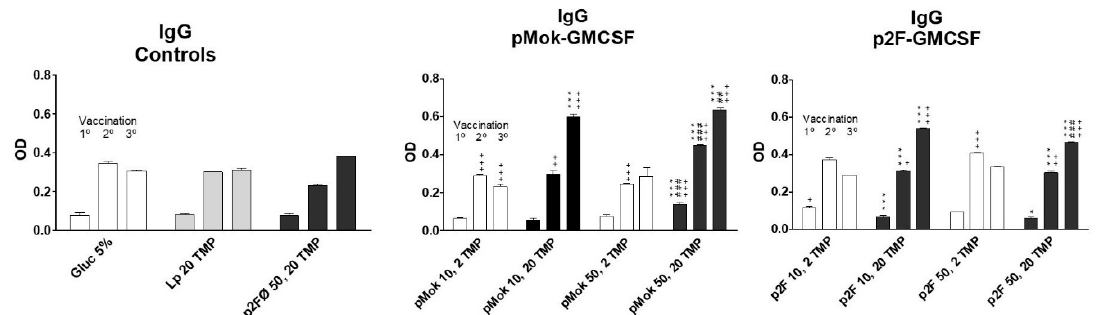
Figure 4. Total IgG response obtained after each vaccination dose in the different formulations of multicompartmental lipopolyplex loaded with a water-soluble protein extract (TMP). Lipolyplexes contained 10 or 50 µg of plasmid (pMok or p2F) bearing murine GM-CSF gene and 2 or 20 µg of TMP. * symbol is employed to define the statistically significant difference due to the amount, 2 or 20 µ g, of TMP (* p < 0.05; *** p < 0.001) in each vaccination. # symbol indicates